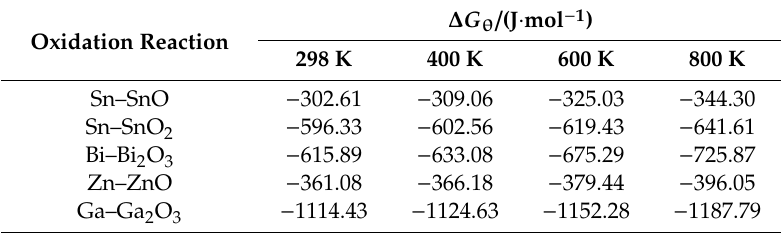
Table 5. Gibbs free energy of the elements in the experimental materials